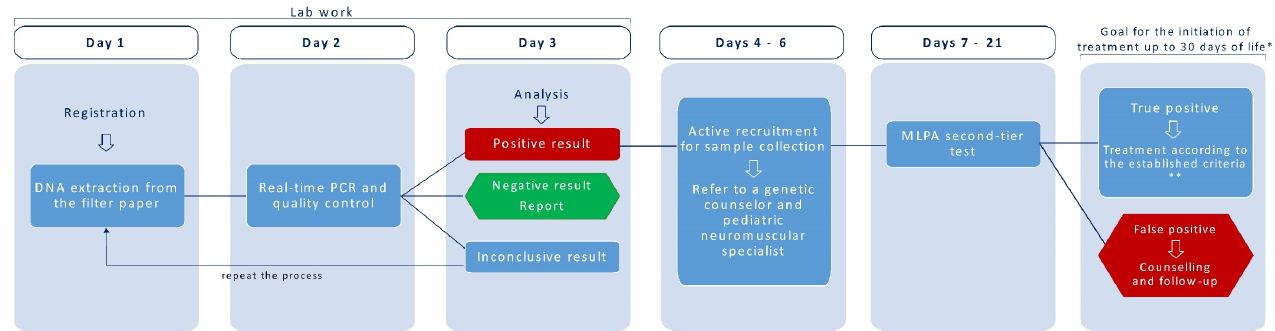
Figure 2. Possible workflow for SMA NBS implementation, along with patient follow-up to treatment. Days 1 − 3 of the laboratory work were based on a calculation of the time for the preparation of 7 to 8 plates (384-well plates) a day (about 1500 samples/day) and our current assay experience; about 2 laboratory specialists would be needed during this workflow. * Based on McMillan et al. [29]. ** International guidelines refer to treating all confirmed SMA infants with 4 SMN2 copies or less. However, the Brazilian PCDT only includes pre-symptomatic patients with up to 3 copies of SMN2 ; this might be a point of significant revision (see Discussion for additional details). Moreover, other factors can be relevant for the clinical indication of the treatments available. The figure was based on, and modified from, McMillan et al.